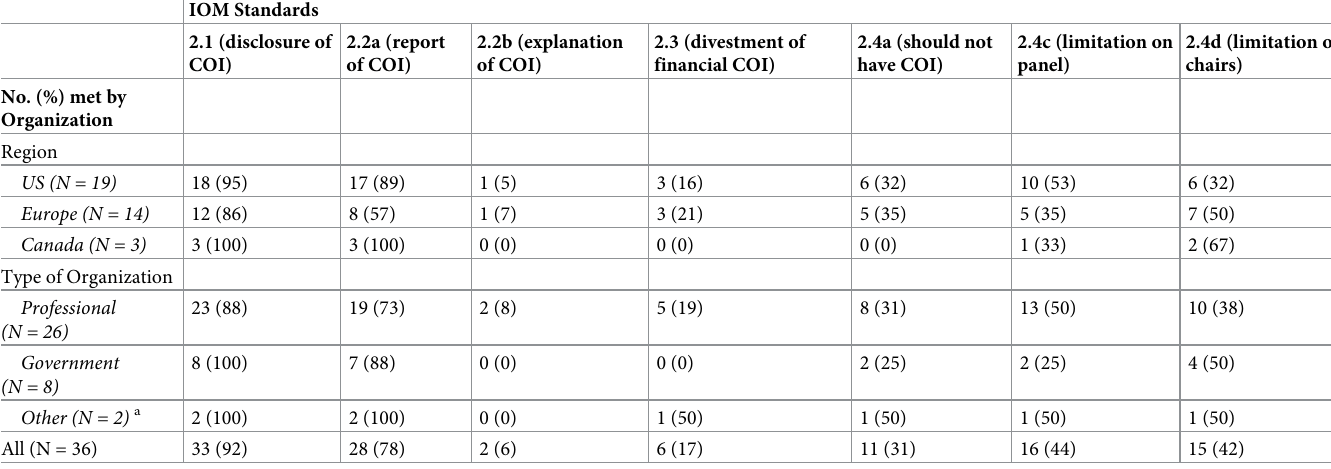
Table 3. Number of organizations with COI policies meeting each IOM standard, stratified by region and type of organization. IOM